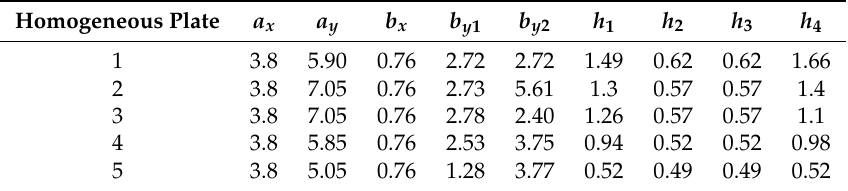
Figure 7. ( a ) cell geometry; ( b ) modified I domain under extensional strains: subtraction of the regions at almost zero-strain. Table 1. Cell geometry; numerical values in